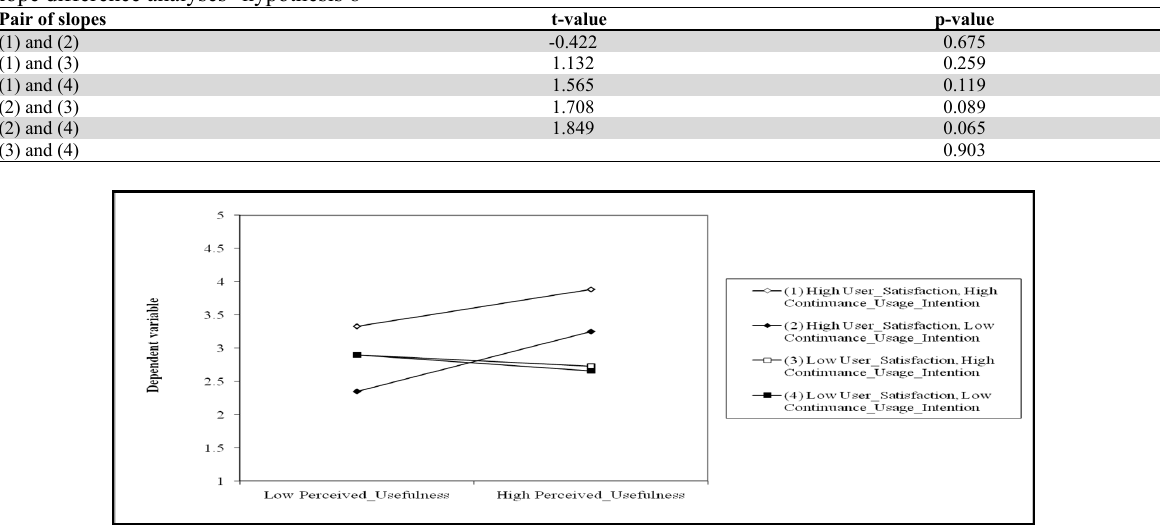
Fig. 6. Interaction effects of user satisfaction & e-HRM continuance usage intention between e-HRM-PU & SCA (Sources: Gaskin,